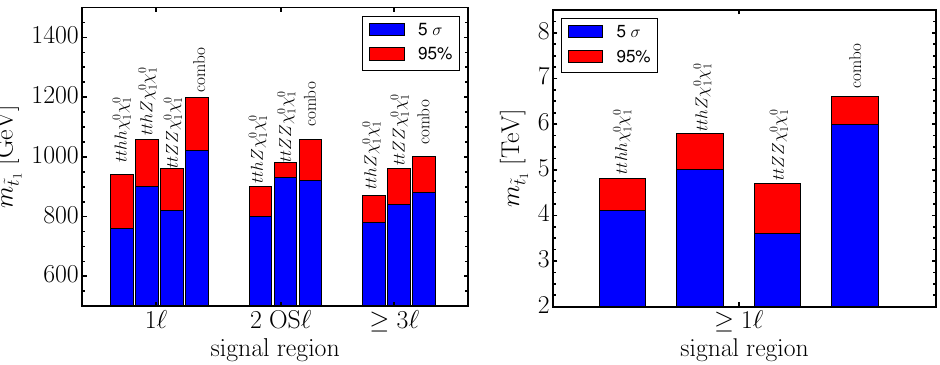
Figure 11 . The 5 (cid:27) discovery reach and 95% exclusion limit of light stop mass for three primary signal regions at the 14 TeV LHC with 300 fb (cid:0) 1 integrated luminosity (left panel) and at least one lepton signal region at the future 100 TeV pp collider with 3000 fb (cid:0) 1 integrated luminosity (right